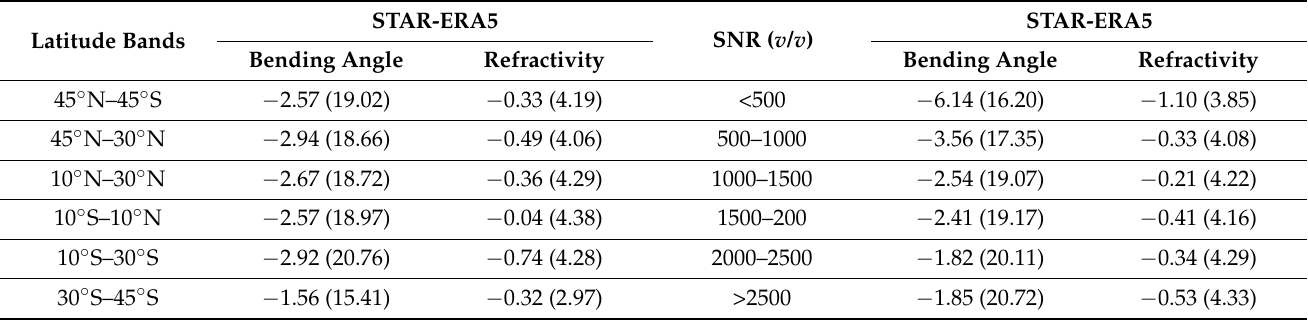
Table 4. The mean and standard deviation (in parenthesis) of the fractional bending angle and refractivity difference between STAR and ERA-5 at different latitude and SNR bands for the 0–2-km height range. Latitude